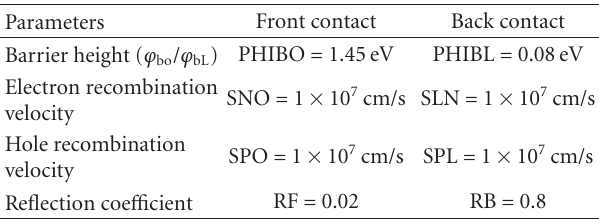
Table 2: General layer